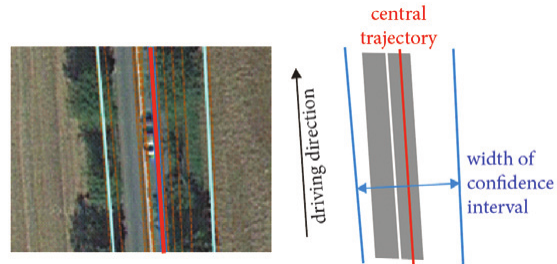
Fig. 2. Holux M-1000C Bluetooth GPS Logger which was used in the pilot study